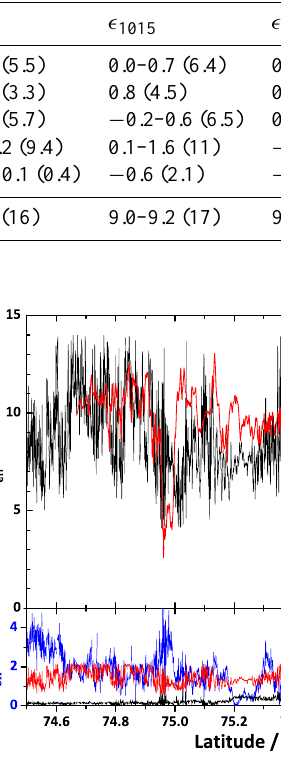
Fig. 7. Cloud-particle effective radius r eff in aircraft nadir retrieved from the SMART-Albedometer radiance. Top panel: r eff retrieved by 2WL (black) and observed by the FSSP (red) at the same lat- itude, but one hour later. Bottom panel: absolute difference 1r eff between 2WL and 5WL (blue); propagated uncertainty u(r eff ) in 5WL (black) and 2WL